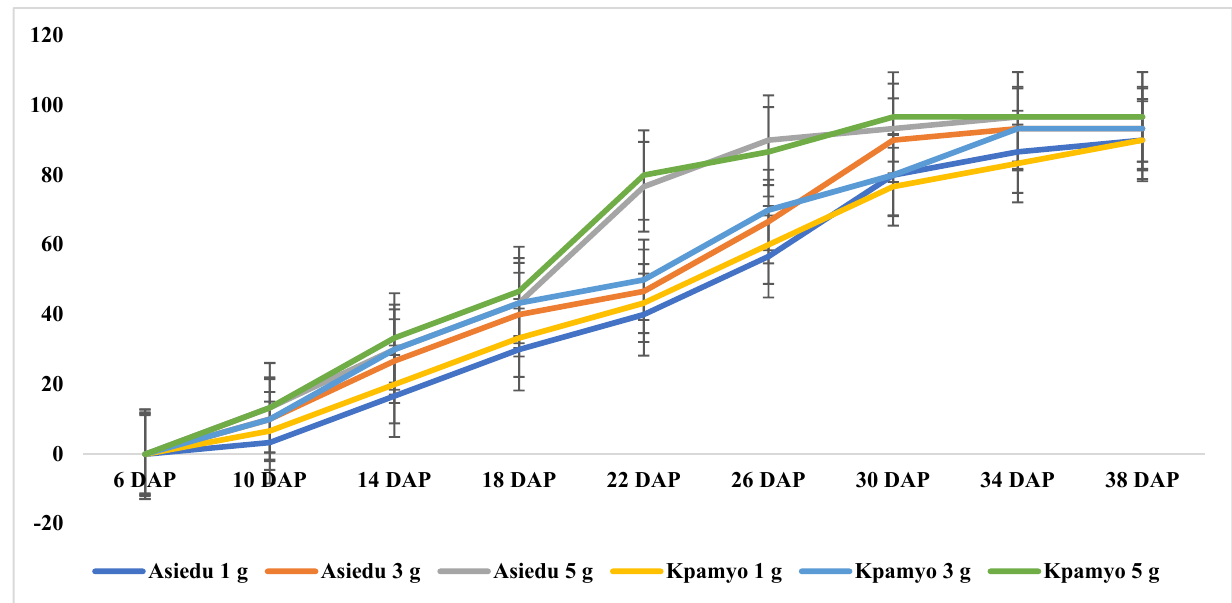
Figure 3. Combined number of days to emergence of minitubers of yam varieties Kpamyo and Asiedu over three years (2017–2019) in Abuja, Nigeria.